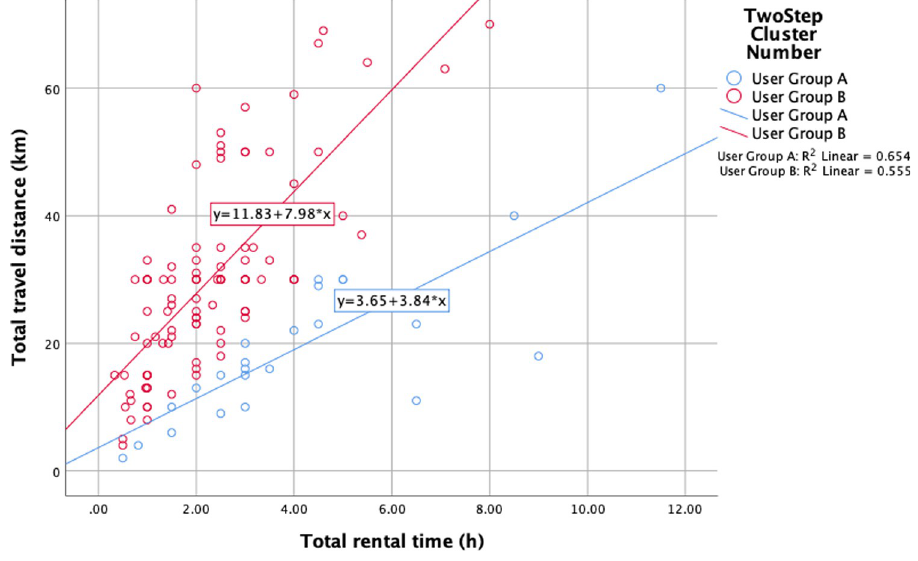
Fig 1. Scatter diagram of user